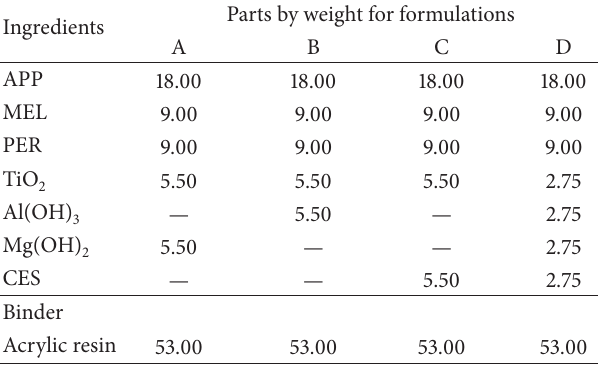
Table 1: Compositions of intumescent fire protective coatings. Parts by weight for Ingredients